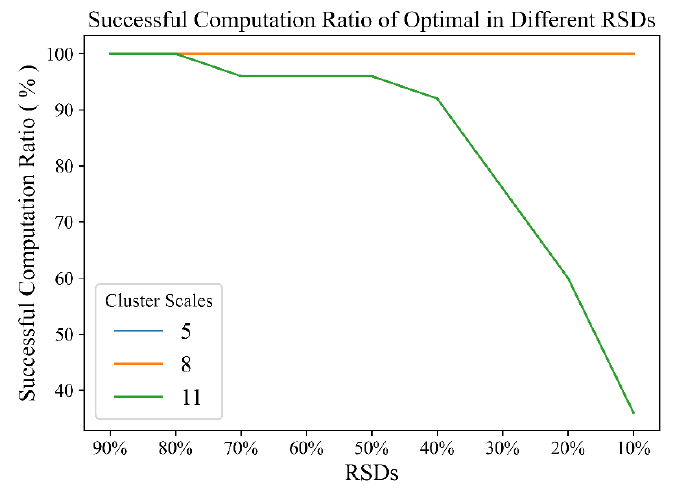
Figure 7. Successful computation ratio of optima under different RSDs and cluster scales. The two lines, blue and orange, coincide with each other.